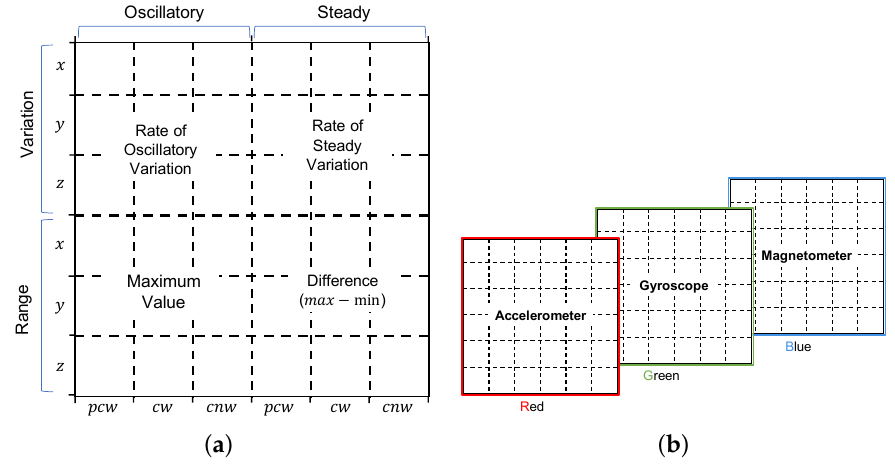
Figure 9. Image representation—Design-B. ( a ) Single channel and ( b )